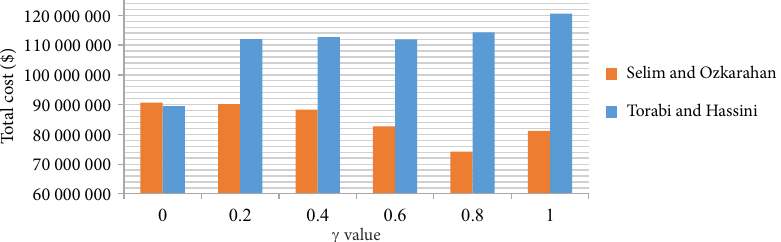
Fig. 4. Comparison of the effects of changing g values on total cost